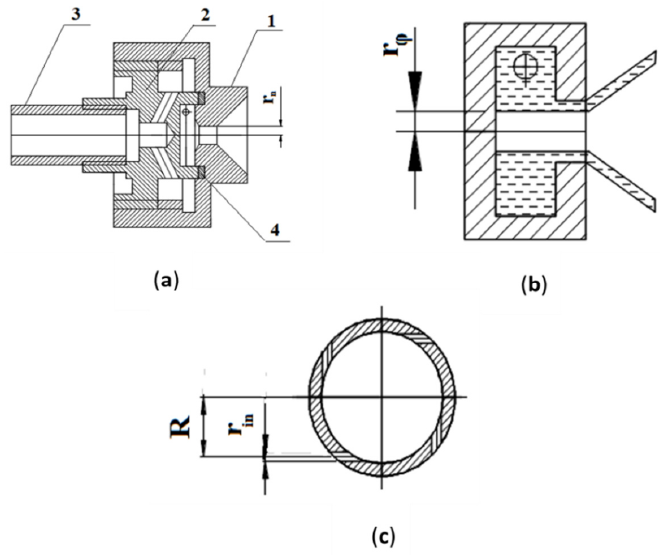
Figure 1. Mechanical atomizer ( a ) Atomizer assembly: 1—body, 2—swirl chamber, 3—adapter, 4—o-ring; ( b ) flow structure; ( c ) swirl chamber geometry.